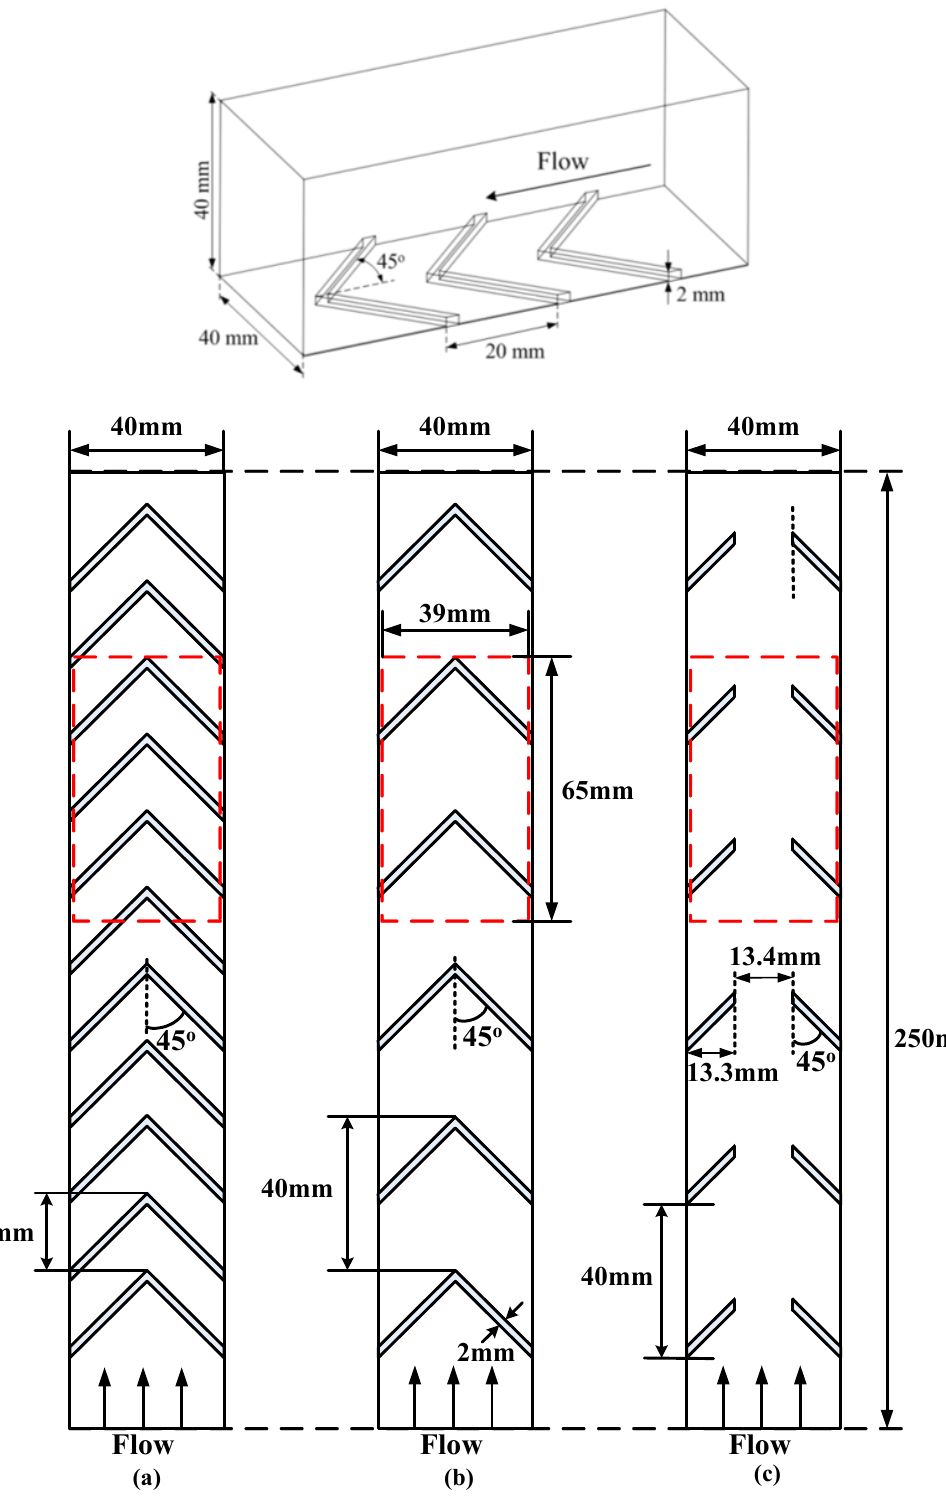
Figure 3. Configuration of the ribs with: ( a ) continuous ( P / e = 10); ( b ) continuous ( P / e = 20) and ( c ) broken-V ( P / e = 20) patterns.